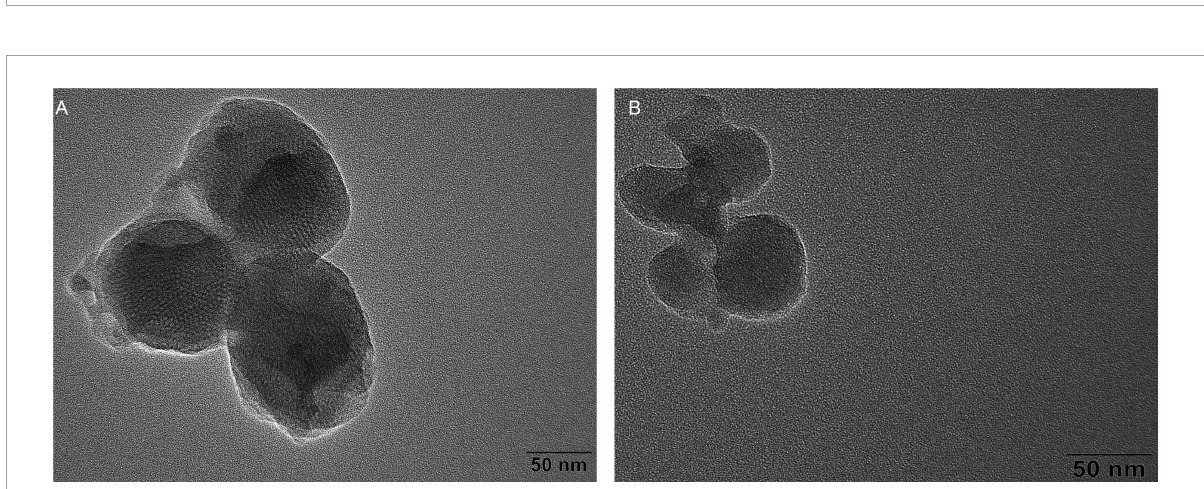
FIGURE2 (A) Transmission electron microscope (TEM) micrograph of MSN; (B) TEM micrograph of MSN-NH 2 .